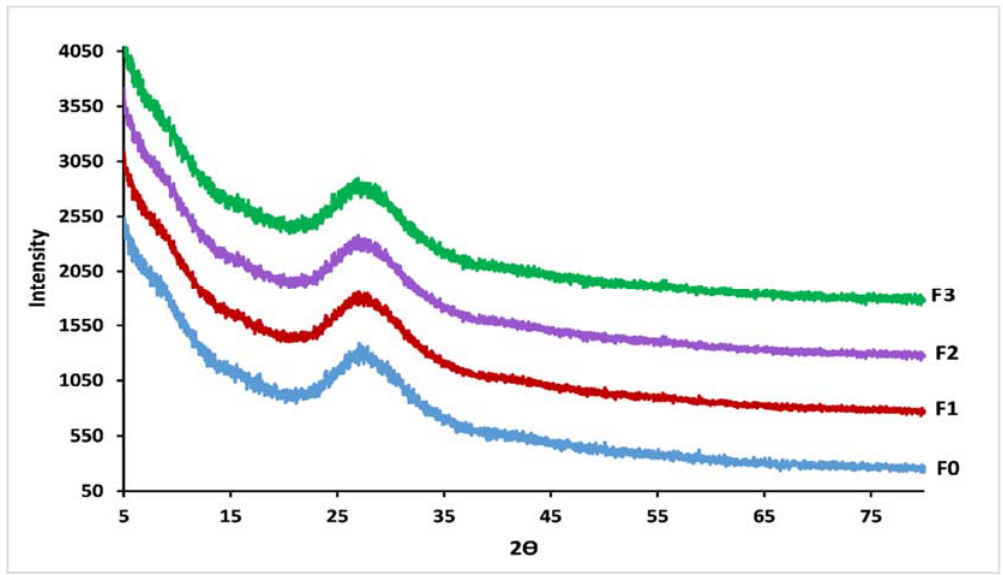
Figure 2. XRD patterns for F 0 , F 1 , F 2 and F 3 glasses.